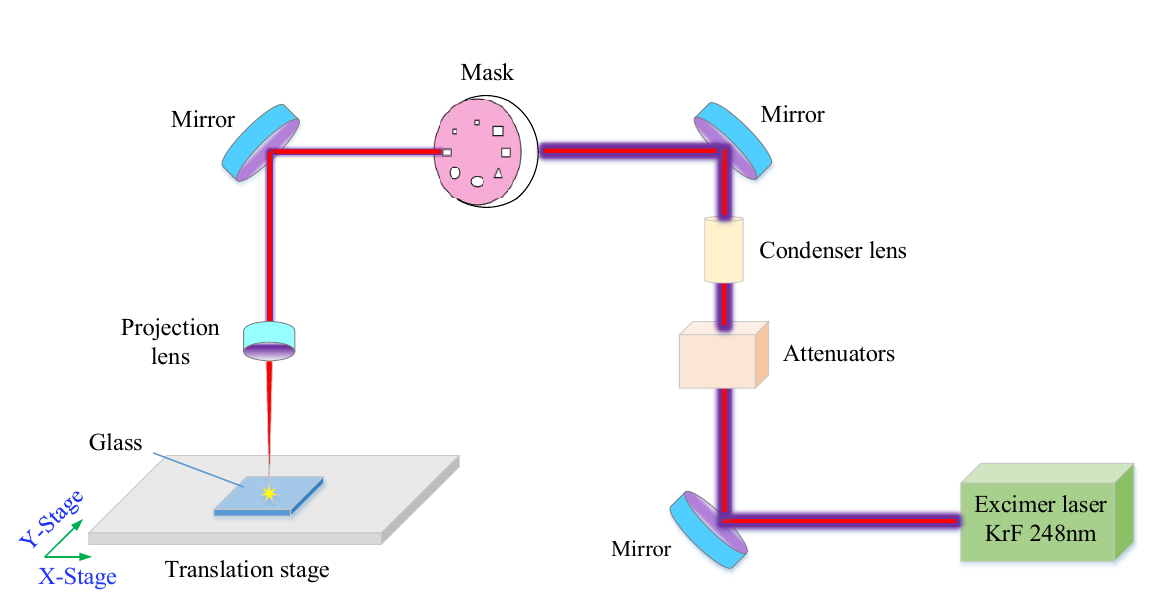
Fig. 1 Schematic of the experimental setup for KrF excimer laser ablation of the